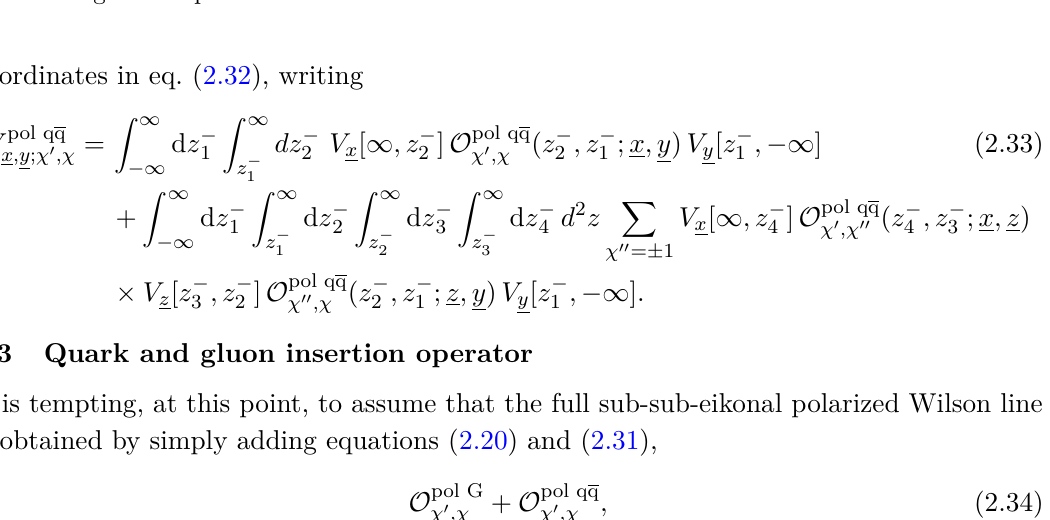
Figure 3. The diagram representing the quark, anti-quark and sub-eikonal gluon field insertions contributing to the quark S -matrix at the sub-sub-eikonal